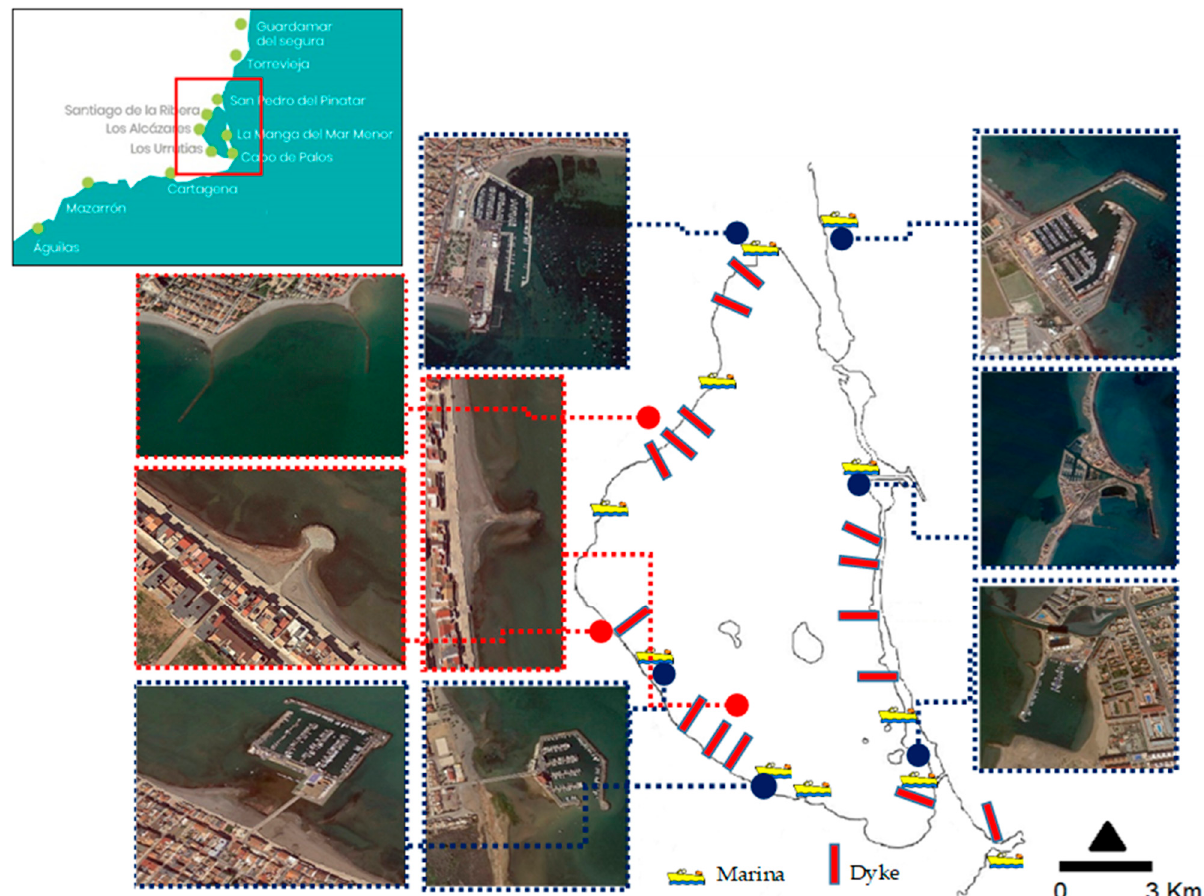
Figure 2. Main coastal towns of the study area (top left) and marinas and coastal infrastructures built in the Mar Menor coastal lagoon since the 1950s (data source: SITmurcia [24]).